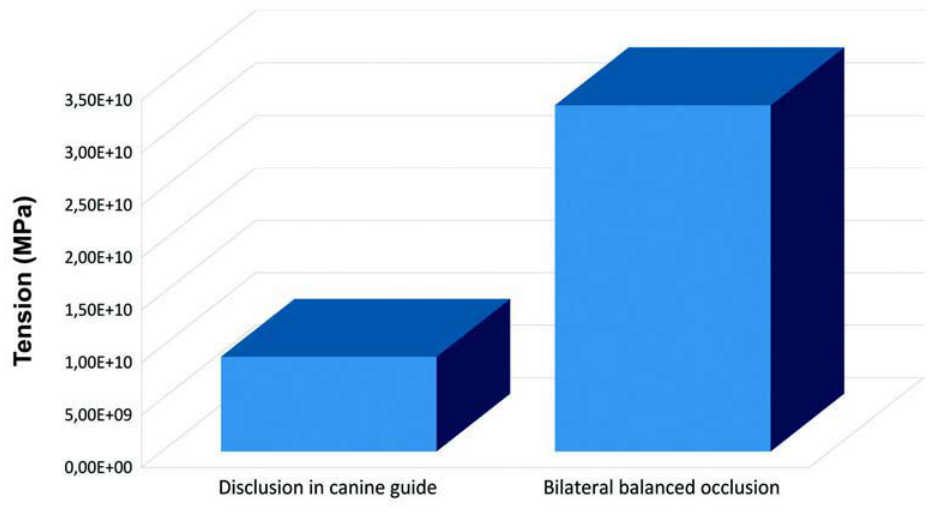
FIGURE 6- Value of maximum tension found in the simulation of disocclusion